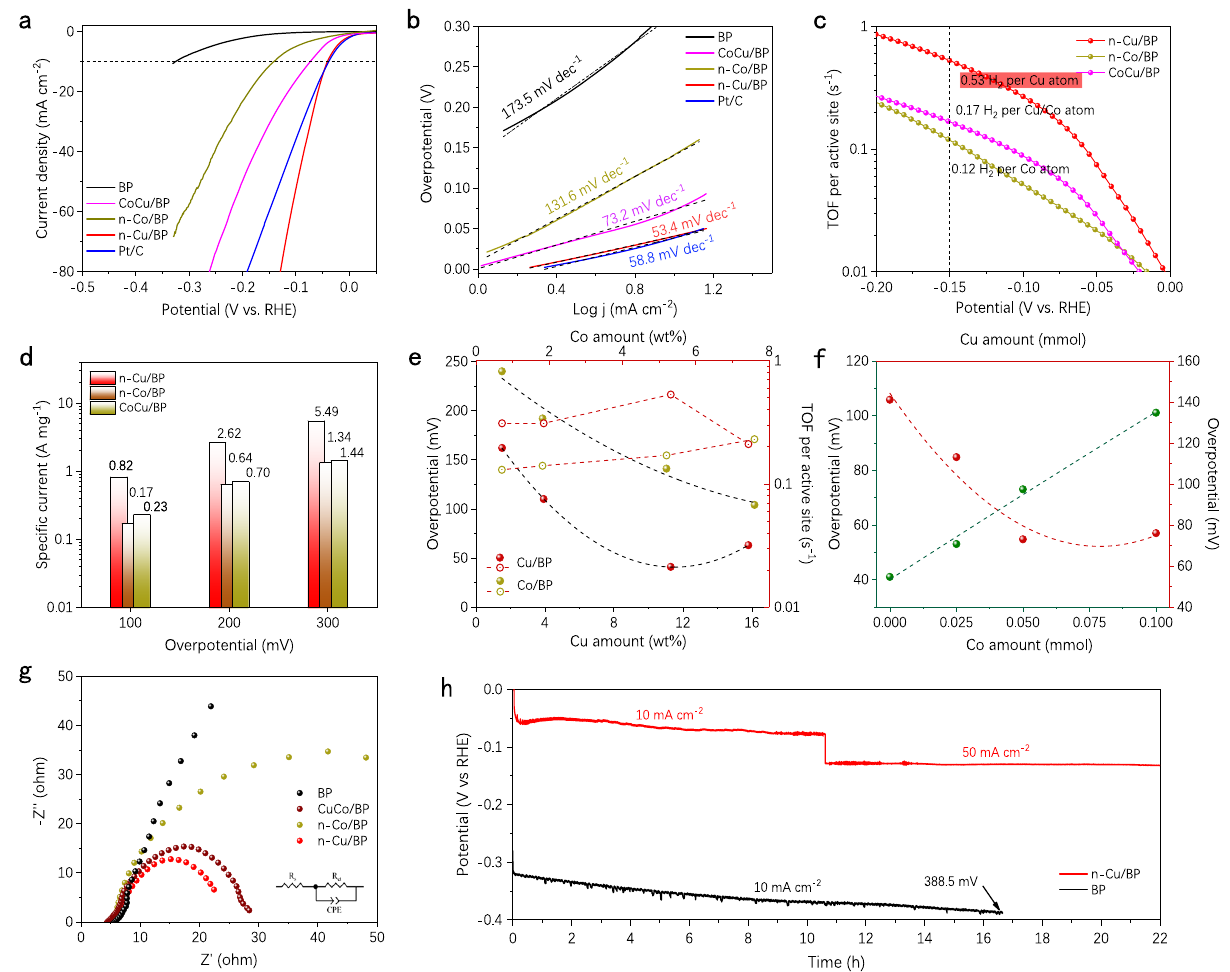
Fig.4|HERperformanceofn-Cu/BPcatalystsandcontrolsamples.a LSVcurves and b Tafel plots of the catalysts in 1M KOH with a scan rate of 5mVs − 1 . c TOFs of Cu, Co, and CuCo atoms on BP at different overpotentials. d Mass activities of the catalystsonthebasisofCu,CoandCuCoatoms. e OverpotentialsofCu/BPandCo/ BP with different Cu and Co loading, respectively, and the corresponding TOFs